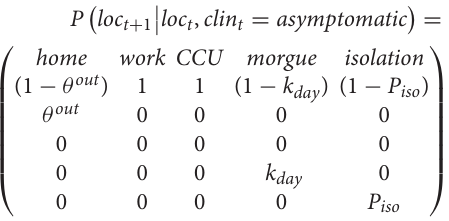
Supplementary Table 1 ) multiplied by a decreasing function of the proportion of infected people. The social distancing, modeled as “the propensity to leave home and expose oneself to interpersonal contacts (14),” is an exponential threshold parameter (see social distancing threshold Supplementary Table 1 ). The transition probabilities